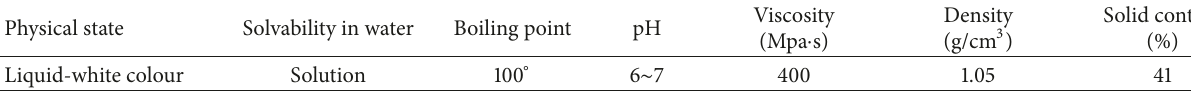
Table 1: Important physicochemical properties of polyvinyl acetate.